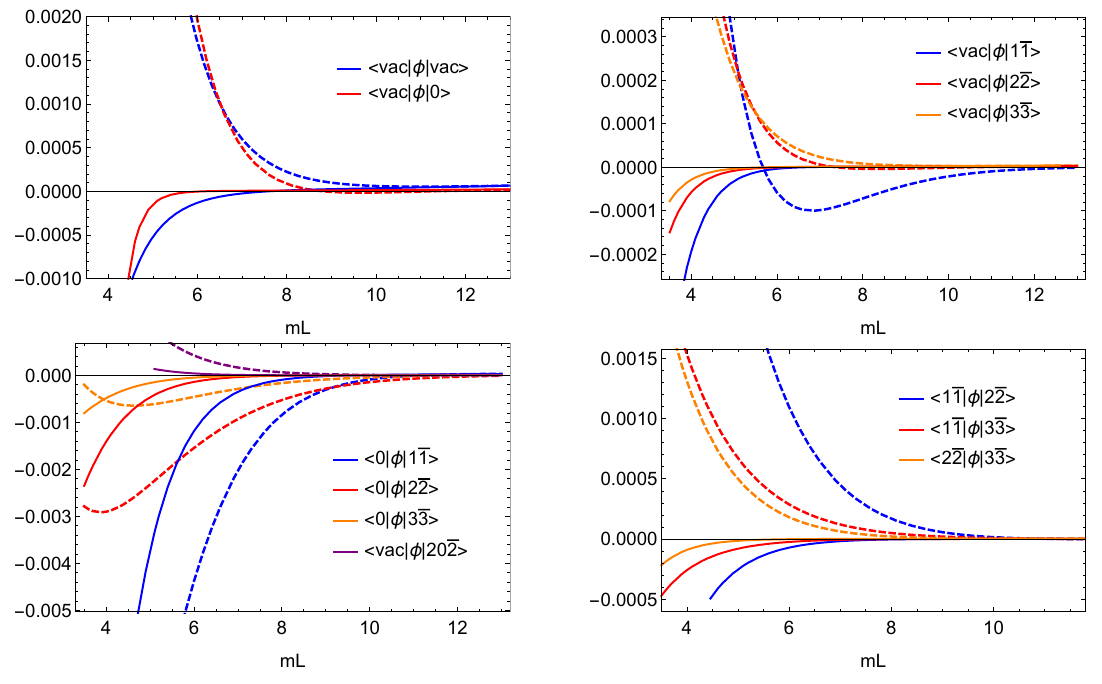
Figure 13 . Representative (cid:12)gures for the polynomial and exponential corrections. Dashed lines are the absolute values of the di(cid:11)erence between the BY and TCSA data, while solid lines are the same for the best available exponential corrections. For the h vac j (cid:8) j vac i diagonal matrix element we show the F-term only. For h vac j (cid:8) jf 0 gi ; h vac j (cid:8) jf n; (cid:0) n gi the best available correction is \ (cid:22) + F while for hf 0 gj (cid:8) jf n; (cid:0) n gi ; h vac j (cid:8) jf 2 ; 0 ; (cid:0) 2 gi ; hf m; (cid:0) m gj (cid:8) jf n; (cid:0) n gi ; n; m = 1 ; 2 ; 3: best available correction is \ (cid:22) + F 1 1